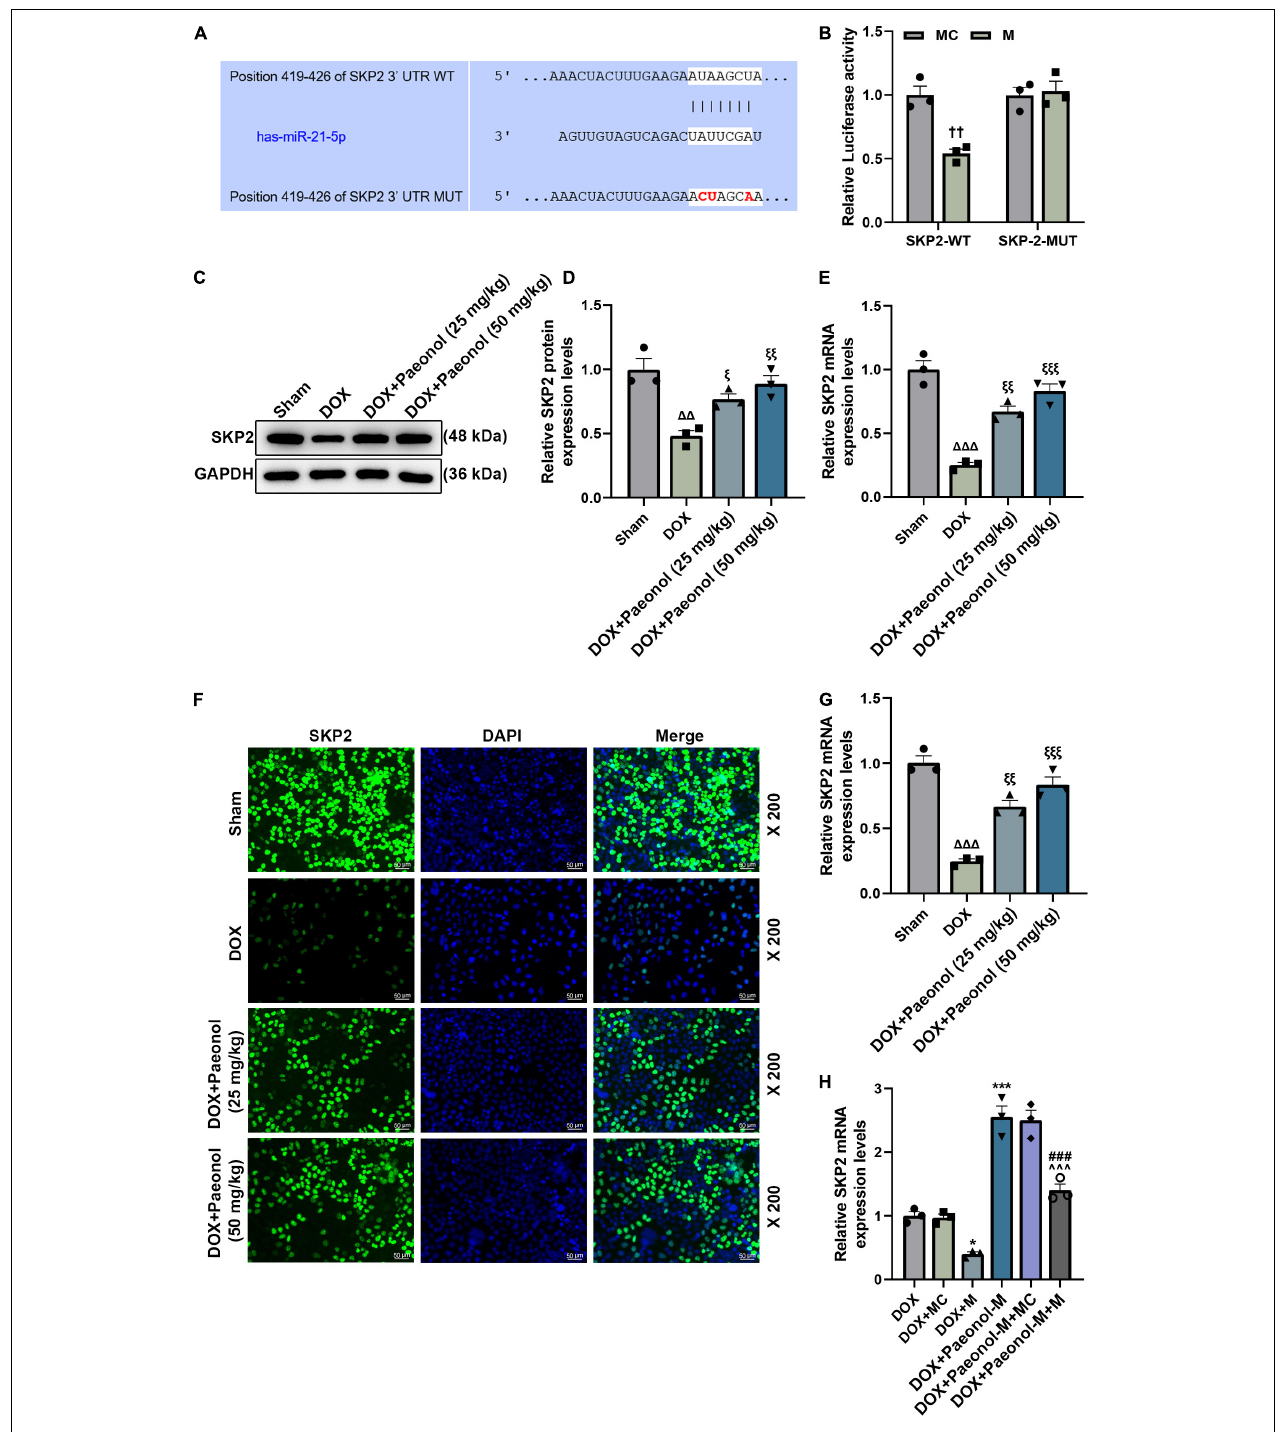
FIGURE 6 | SKP2 was targeted by miR-21-5p and was downregulated in CHF rats and DOX-induced cardiomyocytes. (A) The binding sites between miR-21-5p and SKP2 were predicted by the TargetScan database. (B) Dual-luciferase reporter assay was employed to verify the targeting relationship between miR-21-5p and SKP2. (C,D) The expression of SKP2 in the myocardium of CHF rats was detected by Western blot, with GAPDH serving as an internal control. (E) The expression of SKP2 in the myocardium of CHF rats was detected by RT-qPCR. GAPDH was used as an internal control. (F,G) The expression of SKP2 in the DOX-induced H9c2 cells treated with PAE was detected by immunocytochemistry. (H) The expression of SKP2 in the DOX-induced H9c2 cells treated with miR-21-5p mimic or Paeonol-M was quantified by RT-qPCR. GAPDH served as an internal control. †† P < 0.01 vs. MC; (cid:49) (cid:49) P < 0.01, (cid:49) (cid:49) (cid:49) P < 0.001 vs. Sham; ξ P < 0.05, ξ ξ P < 0.01, ξ ξ ξ P < 0.001 vs. DOX; * P < 0.05, *** P < 0.001 vs. DOX + MC; ### P < 0.001 vs. DOX + M; ∧∧∧ P < 0.001 vs. DOX + PAE-M + MC. DOX, doxorubicin; M, miR-21-5p mimic; MC, mimic control.